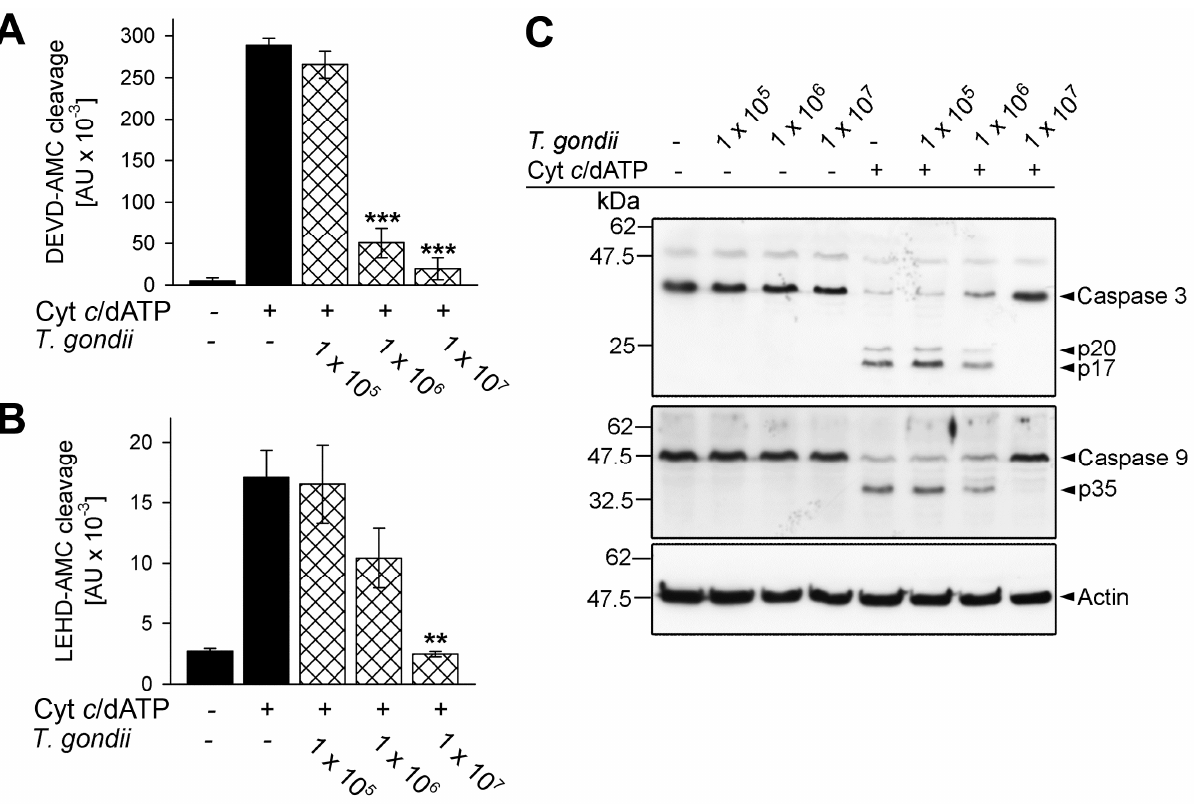
FIGURE 1: T. gondii inhibits cytochrome c -induced activation of the caspase 9-caspase3/7 cascade in cell-free cytosolic extracts. (A, B) Cell-free cytosolic extracts of Jurkat cells were incubated with increasing amounts of parasites as indicated (cross-hatched bars; no. of para- sites per 0.1 ml) or were left untreated (black bars). After 1 hour, caspase activation was triggered or not by cytochrome c and dATP. Cleav- age of the caspase 3/7 substrate DEVD-AMC (A) or of the caspase 9 substrate LEHD-AMC (B) was measured fluorimetrically. Data represent the increase in substrate cleavage over time; they represent means ± S.E.M. from at least 3 independent experiments. Significant differences were identified by Student’s t -test (** P < 0.01; *** P < 0.001). (C) Cell-free cytosolic extracts incubated or not with T. gondii as indicated and incubated or not with cytochrome c /dATP to trigger caspase activation were resolved by SDS-PAGE. After protein transfer to nitrocellu- lose, membranes were probed with antibodies recognizing caspase 3, caspase 9 and actin. Immune complexes were visualized using peroxi- dase-conjugated secondary antibodies and enhanced chemiluminescence detection. The experiment was repeated once with similar